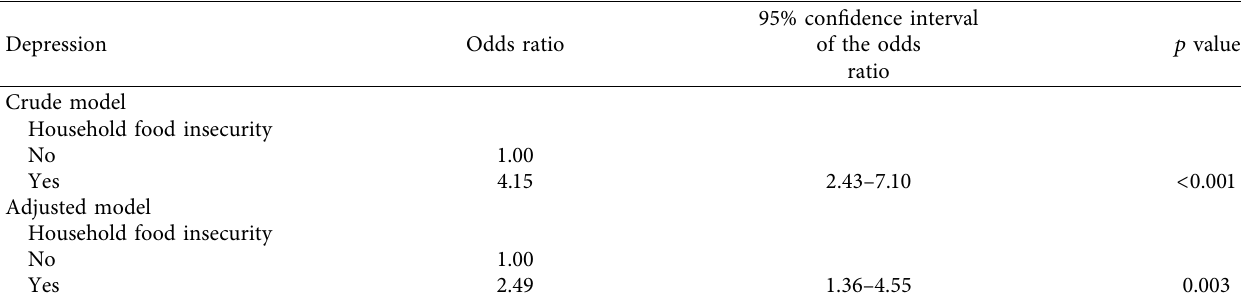
Table 4: Association between household food insecurity and depression